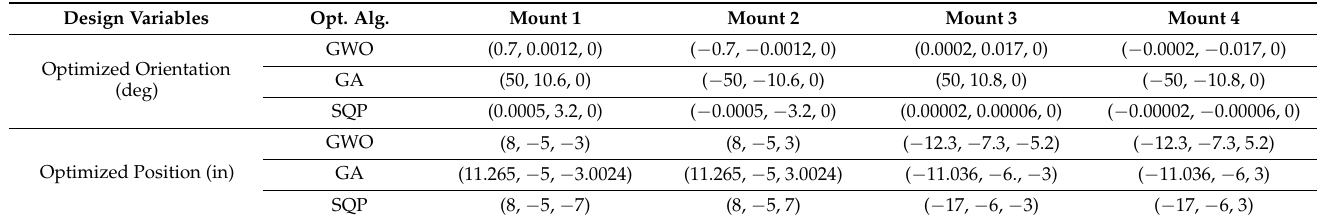
Table 6. Optimized mounts’ position and orientation (12-DOF model—shaking loads only).